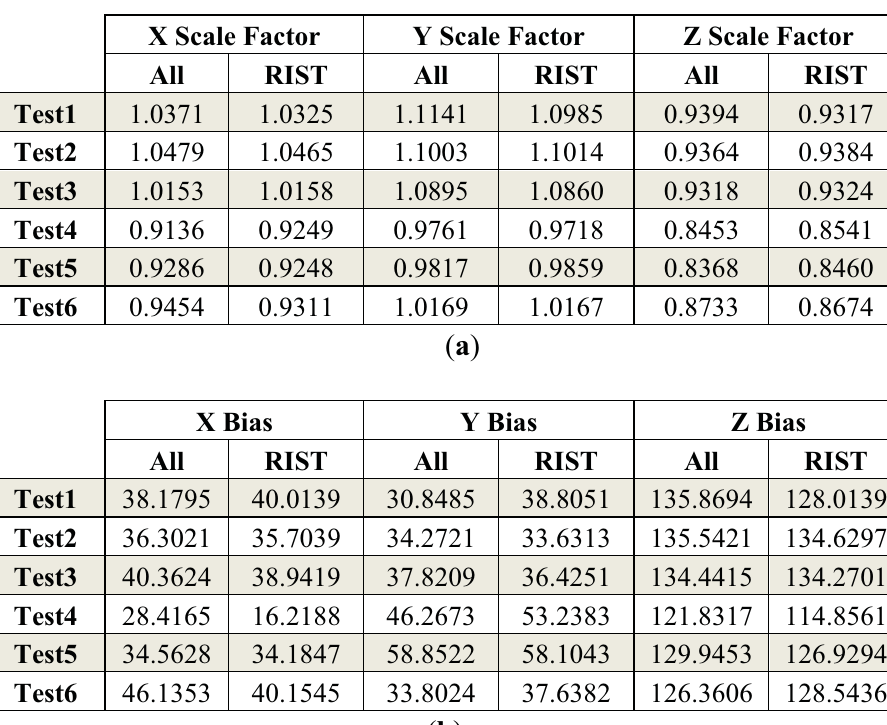
Table 3. Magnetometers parameters resulted from using the entire dataset and RIST in 3-D calibration. ( a ) Scale factor. ( b )